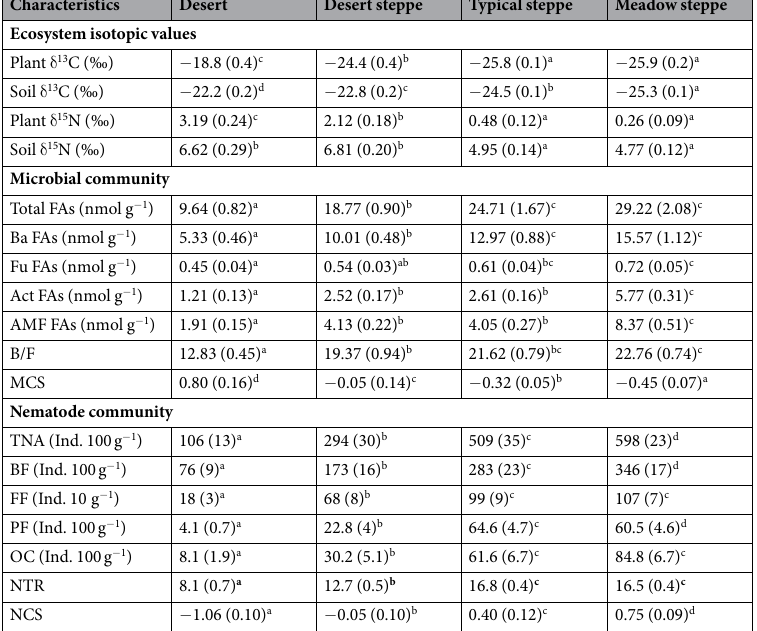
by roots are a major source of available C and N for belowground communities 27, 28 . In addition, the availability of C is a better predictor of belowground communities than the availability of N 7, 29 . H2: We hypothesize that the isotopic values will be more closely associated with soil microbes than with soil nematodes along the envi- ronmental gradients. Because bottom-up effects derived from C and N substrates are often depend on trophic levels in micro-food web, with stronger effects on lower trophic levels (e.g., soil microbes) than on higher trophic levels (e.g., soil nematodes) 30–32 . H3: We hypothesize that, after considering ecosystem stable isotopic values, the explanation of the variance in belowground communities will be greatly improved than the situations which only consider environmental variables. Because stable isotope information can provide insight not only into envi- ronmental variables but also into water-use efficiency and terrestrial ecosystem functions along environmental gradients 13, 14, 22 . Relationships between isotopic values and belowground communities. (Table S1). Soil δ 13 C decreased from − 22.2 to − 25.3‰, and plant δ 13 C decreased from − 18.8 to − 25.9‰ (Table 1). Similarly, soil δ 15 N decreased from 6.62 to 4.77‰, and plant δ 15 N decreased from 3.19 to 0.26‰ (Table 1). For microbes, total soil microbial biomass, biomass of all microbial groups, B/F ratio increased while microbial community structure decreased from desert to meadow steppe (Table 1). For nematodes, total nema- tode abundance, abundance of four nematode trophic groups, nematode taxon richness, and nematode commu- nity structure increased from desert to meadow steppe (Table 1). Regression analyses showed that ecosystem isotopic values were closely associated with most variables in belowground communities (Figs 2–4). Ecosystem δ 13 C values (plant and soil) were negatively related to total microbial biomass, the biomass of all four microbial groups, and B/F ratios, and were positively related to micro- bial community structure across the Mongolian Plateau (Figs 2A and 4A). Plant δ 15 N values were negatively related to total microbial biomass, the biomass of all four microbial groups, and B/F ratios while were positively related to microbial community structure. Soil δ 15 N values, however, were not related to any of the microbial var- iables (Figs 2B and 4B). Ecosystem δ 13 C or 15 N values were negatively associated with total nematode abundance, the abundance of all nematode trophic groups, nematode taxon richness, and nematode community structure (Figs 3 and 4C). Soil nematode variables were more closely associated with ecosystem δ 13 C values than with eco- system 15 N values (Figs 3 and 4D).